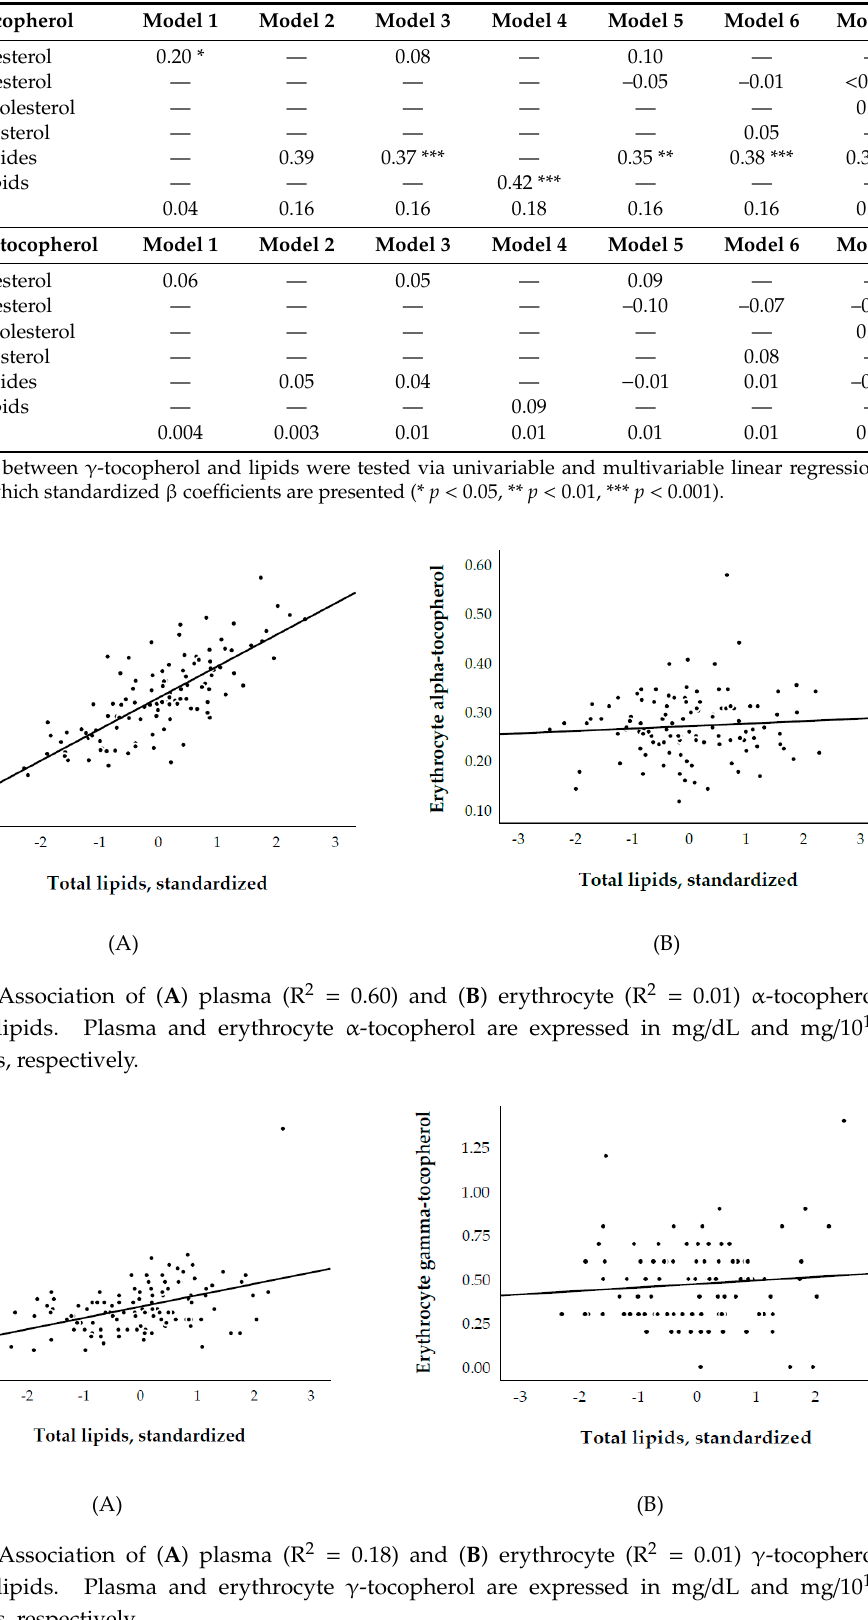
Table 2. Association between plasma and erythrocytes γ -tocopherol and fasting lipids in renal transplant recipients ( n = 113).